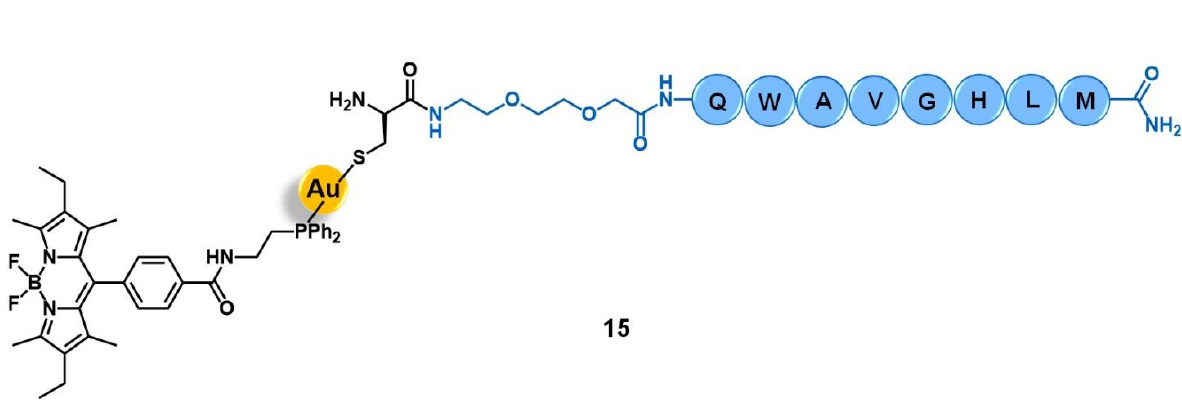
Figure 6. Ru(II) and Au(I) conjugates with peptides that target the bombesin receptors (BBR).